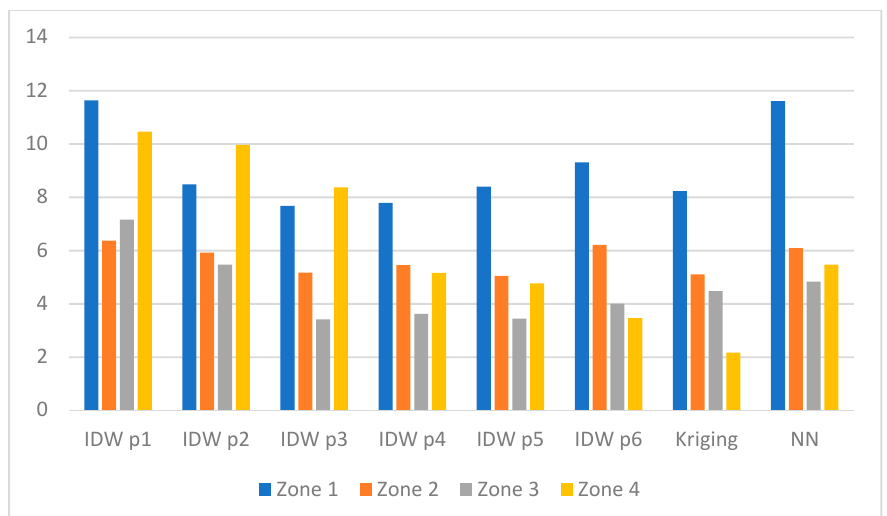
Figure 7. RMSE in zones (value in dB) for Test_26a.